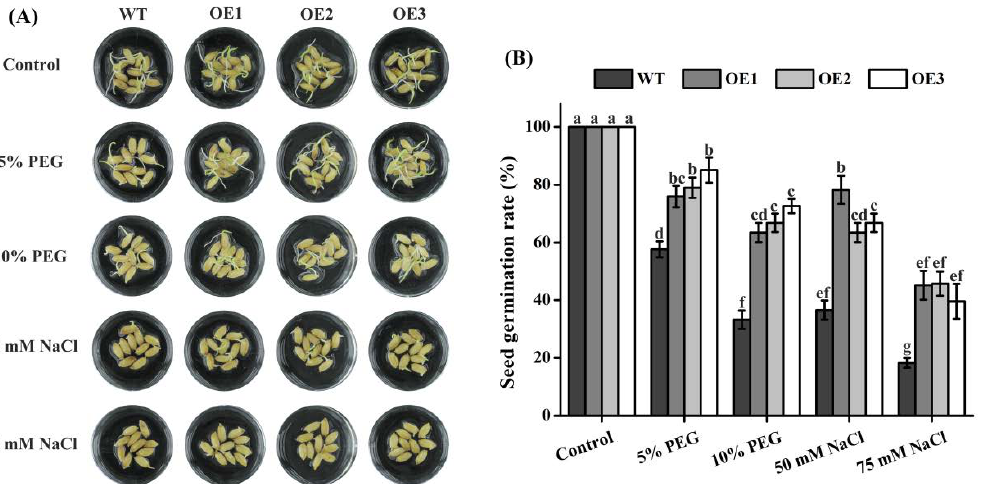
Figure 5. Effects of PEG6000 and NaCl on seed germination of rice WT and TaTIP4;1 overexpressors. ( A ) Seed germination performances. Seeds of WT, OE1, OE2 and OE3 were germinated in the absence or presence of 5% PEG6000, 10% PEG6000, 50 mM NaCl or 75 mM NaCl for 7 days. ( B ) Seed germination rates of all lines in ( A ). Data are mean ± SD (n ≥ 3). Distinct lowercase letters above the error bars show that the data of various plants significantly differed from each other by one way ANOVA and Tukey’s HSD test ( p < 0.05).